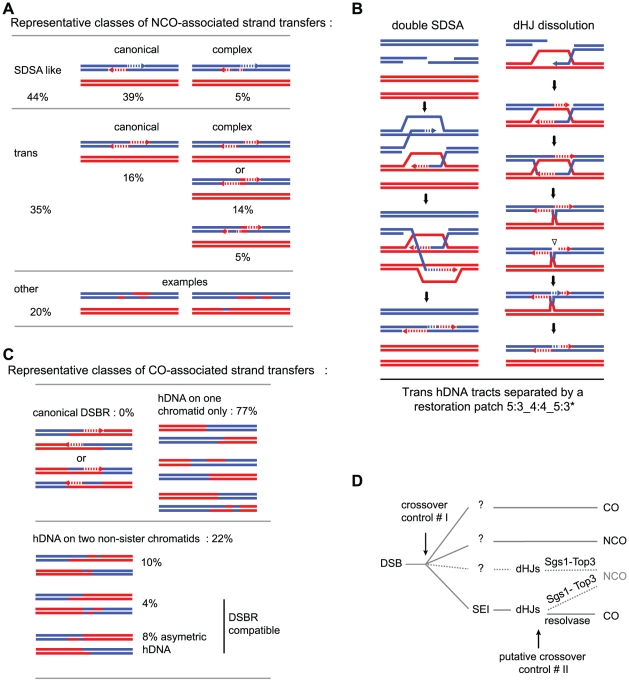
Representative classes of NCO- and CO-associated strand transfers and model for meiotic crossover control points.(A) Representative classes of NCO-associated strand transfers are expressed as percentages of total NCOs. The “SDSA-like” and the “trans” classes are divided in two sub-classes: the canonical sub-classes with the expected patterns from the canonical models (Figure 1a, b and c respectively) and the complex sub-classes with patterns presenting the expected profiles plus additional unpredicted 6∶2 or 4∶4 tracts. The “other” class contains NCOs with strand transfer patterns that cannot be attributed unambiguously to a specific origin. (B) Models for the formation of 4∶4 tracts within trans hDNAs associated to NCOs. During double SDSA, one end invades a non-sister chromatid as expected while the second end first invades the sister chromatid then a non-sister chromatid. Annealing of the two ends leads to the formation of a trans hDNA pattern with a 4∶4 tract in the middle. During dHJ dissolution, an unrepaired nick formed before or during the topological processing of the junction can induce nick translation, which generates a 4∶4 tract. (C) Representative classes of CO-associated strand transfers are presented as percentages of total COs with detectable strand transfer. For the “canonical DSBR” class, the two expected patterns are represented (see Figure 1e). The “hDNA on one chromatid” class and the three sub-classes of “hDNA on two non-sister chromatids” are illustrated by examples of observed patterns. The two “DSBR compatible” sub-classes of hDNA on two non-sister chromatids correspond to situations where the strand transfers from the two non-sister chromatids do not overlap. (D) In addition to the first CO control point before or during the transition between DSB and invasion of the homolog by one end of the DSB, our observations support a model where dHJs can be dissolved into NCOs and therefore constitute a second CO control point. The question marks indicate that except SEIs, no recombination intermediates have been isolated for the other pathways.